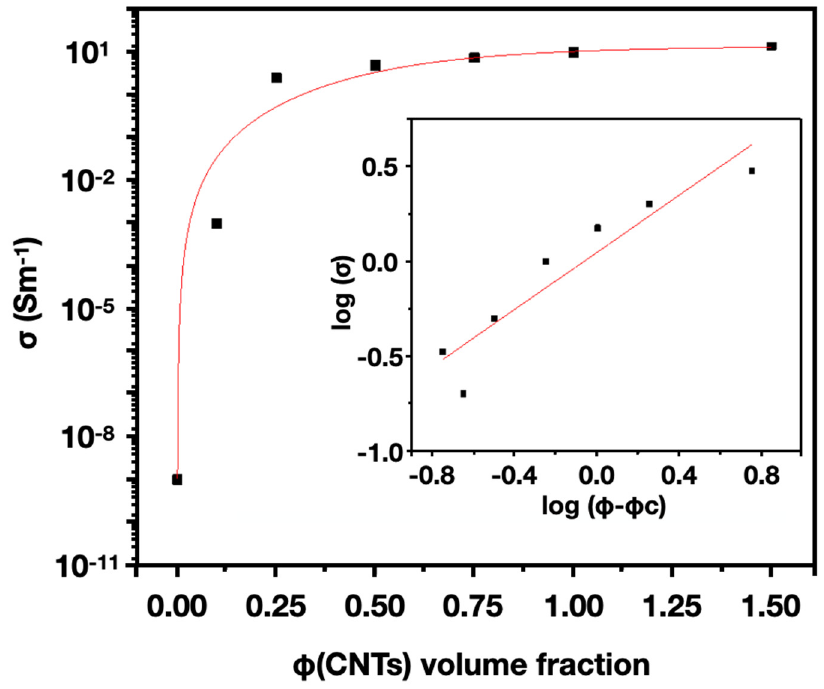
Figure 4. Electrical conductivity of epoxy samples as a function of filler content.